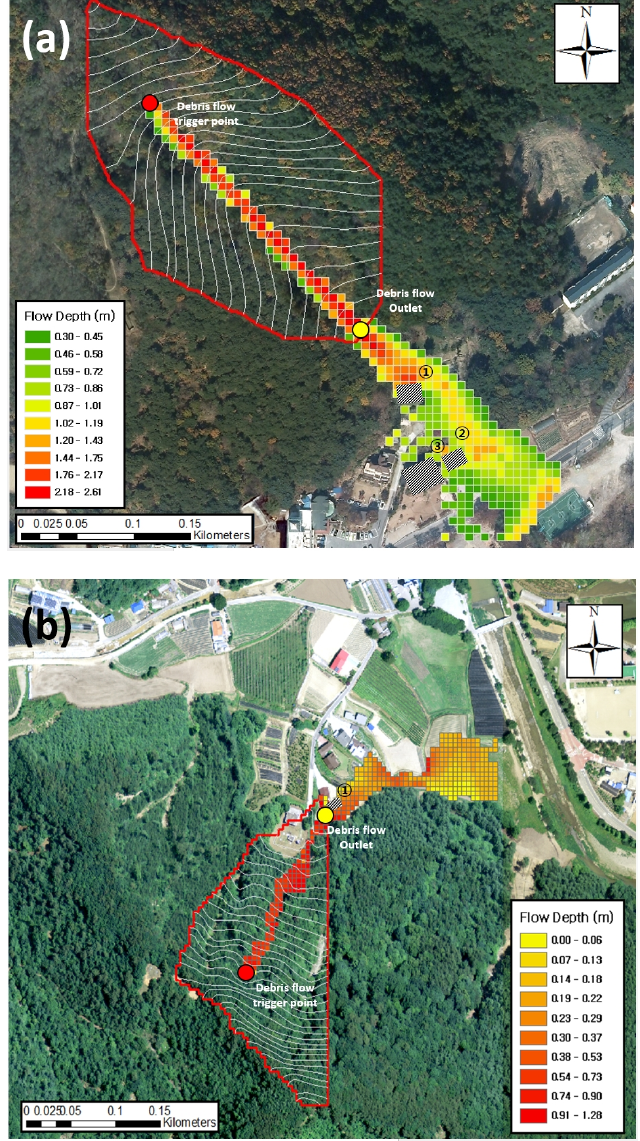
Figure 4. Result of debris flow simulation: ( a ) Site A, Chuncheon-shi area, ① and ② were completely destroyed, and ③ was slight broken; ( b ) Site B, Cheongju-shi area, ① was completely destroyed. The yellow circles indicate debris flow outlets.